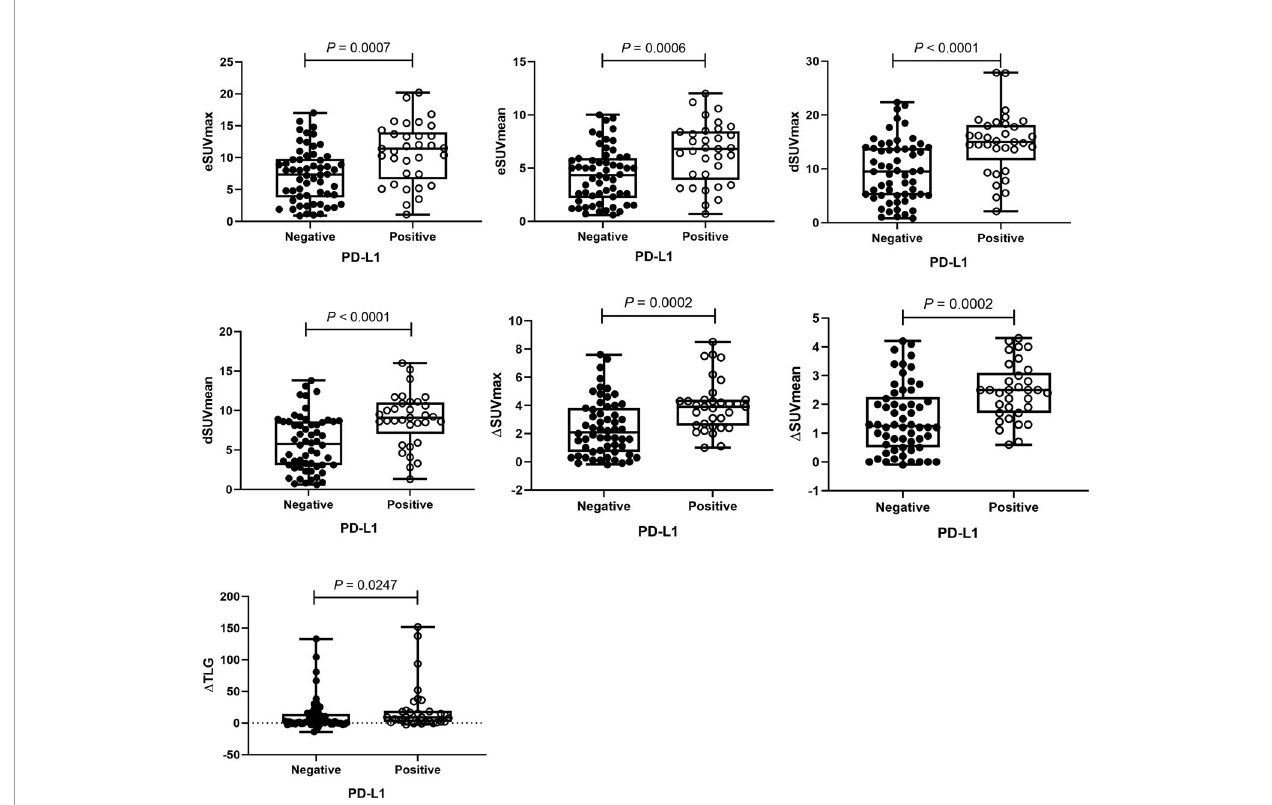
FIGURE 2 | The distributions of metabolic parameters (MPs) according to programmed cell death ‐ ligand 1 (PD ‐ L1) protein expression. The MPs were signi fi cantly higher in patients with PD ‐ L1 positivity than those with PD ‐ L1